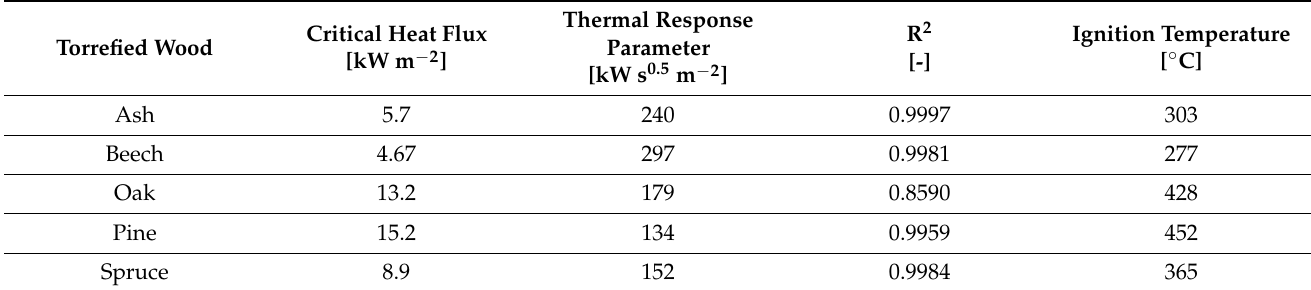
Table 8. Critical heat flux and thermal response parameter of torrefied wood.